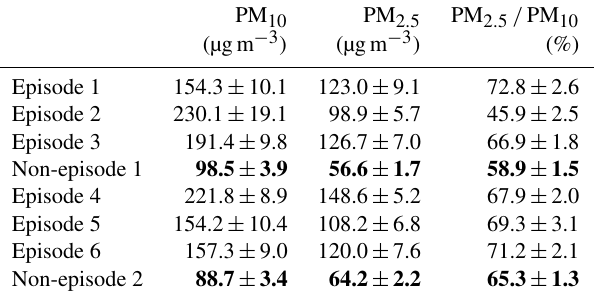
Table 2. Mean PM 10 , PM 2 . 5 , and PM 2 . 5 / PM 10 with 95%CI dur- ing PM 2 . 5 episodes and non-episodes in Wuhan. Non-episode 1 and Non-episode 2 represent the non-episode periods in summer and au- tumn, respectively. The values during non-episodes were in bold to facilitate